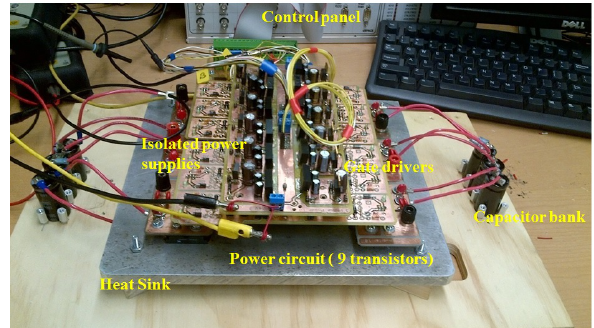
Figure 7: photo of 12 -switch converter